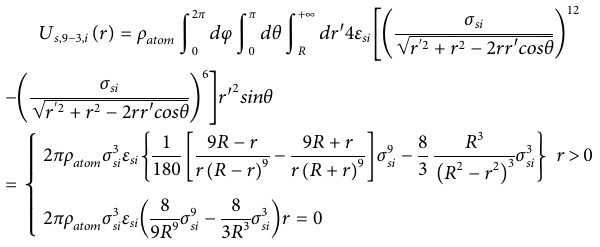
Frontiers in Chemistry |